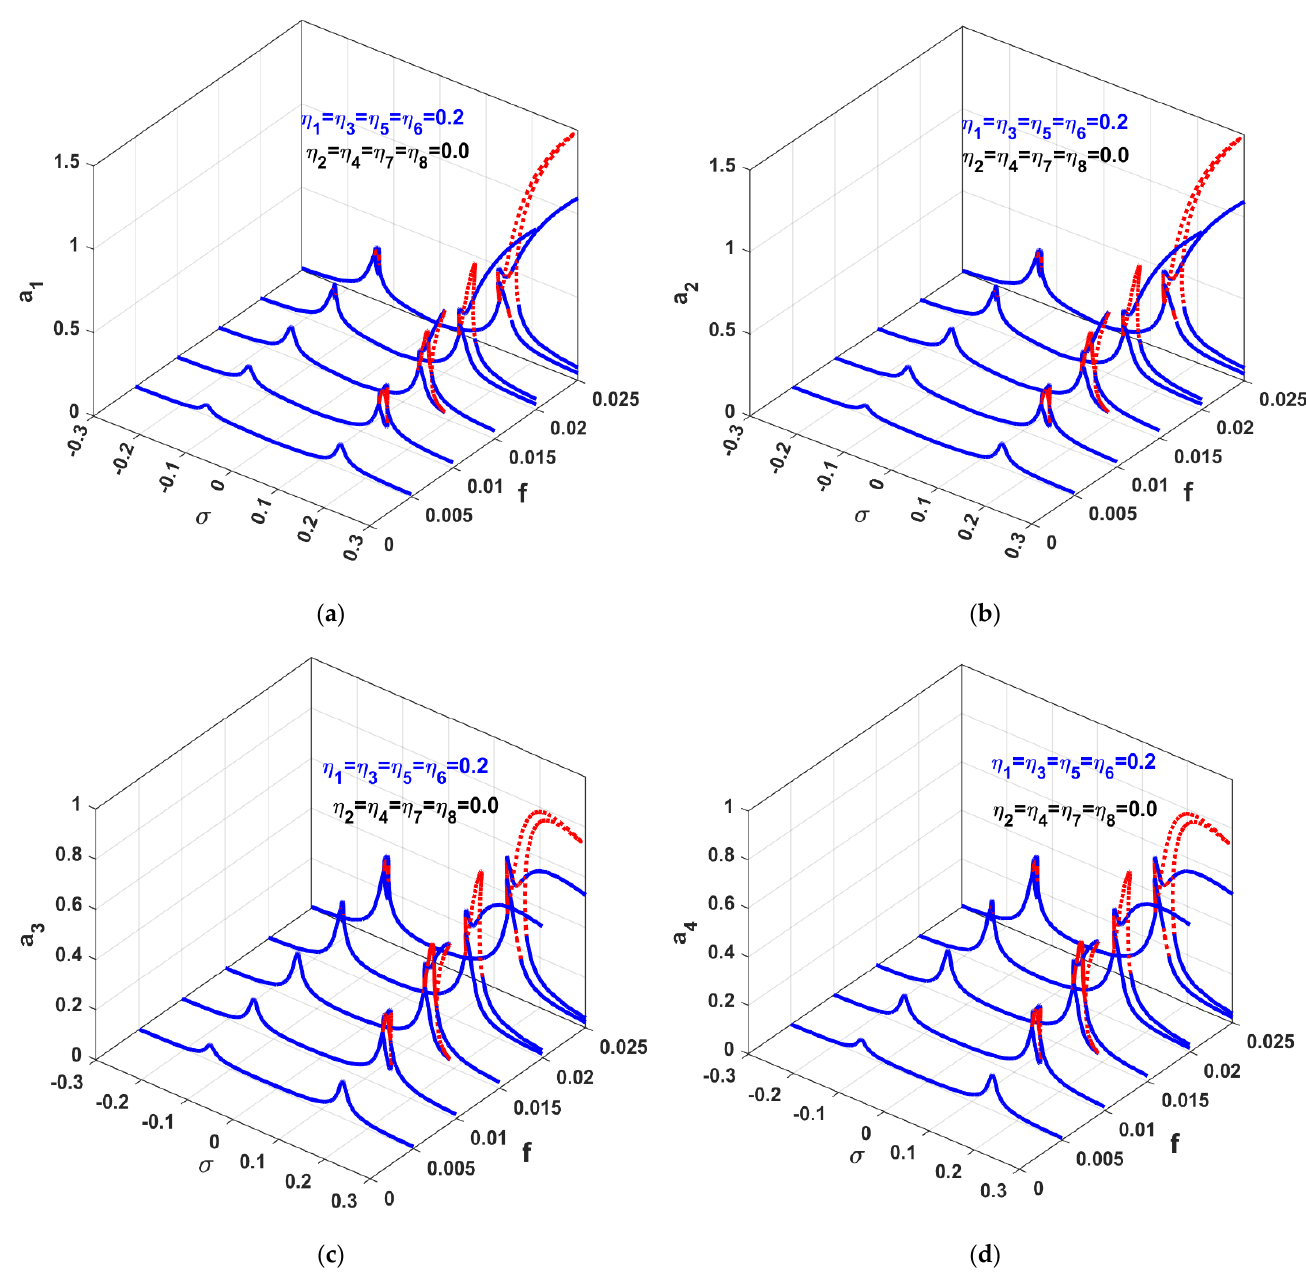
Figure 4. Vibration amplitudes of the rotor system and PPF-controller using 𝜎 as a bifurcation parameter when 𝑓 = 0.005, 0.01, 0.015,0.02, and 0.025 : ( a ) vibration amplitude in 𝑋 1 direction, ( b ) vibration amplitude in 𝑋 2 direction, and ( c , d ) vibration amplitudes of the PPF-controller.